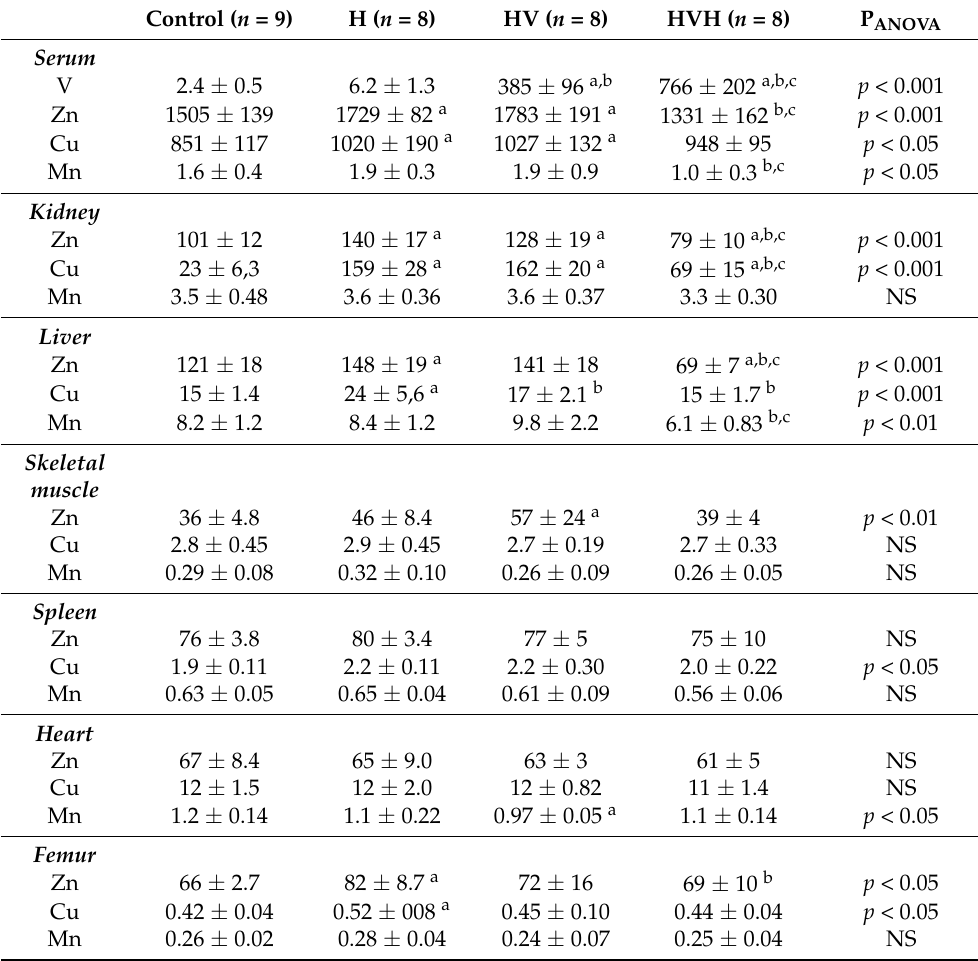
Table 2. Vanadium, zinc, copper and manganese content in serum ( µ g/L) or dry tissue (mg/kg) from the kidney, liver, skeletal muscle, spleen, heart and femur on day 35.